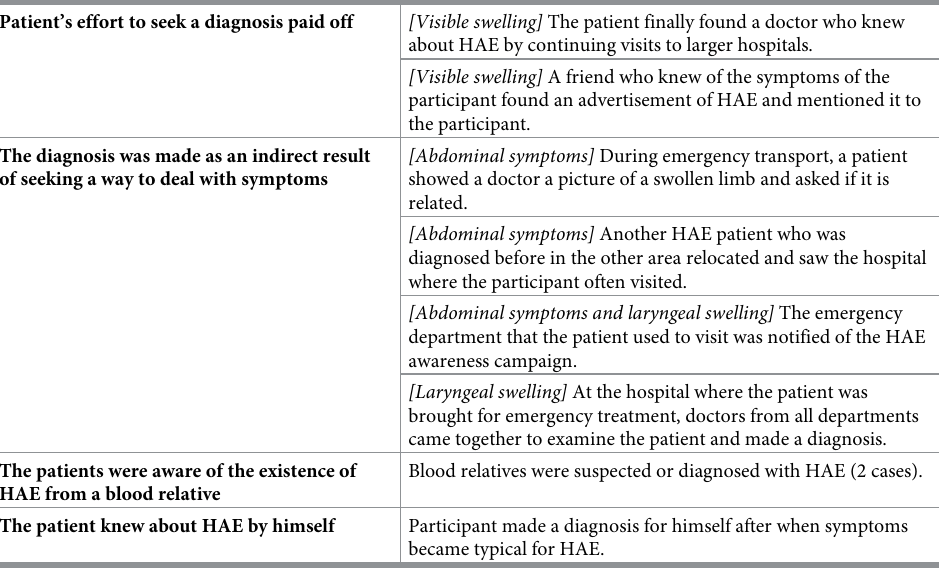
Table 4. How participants reached a diagnosis of